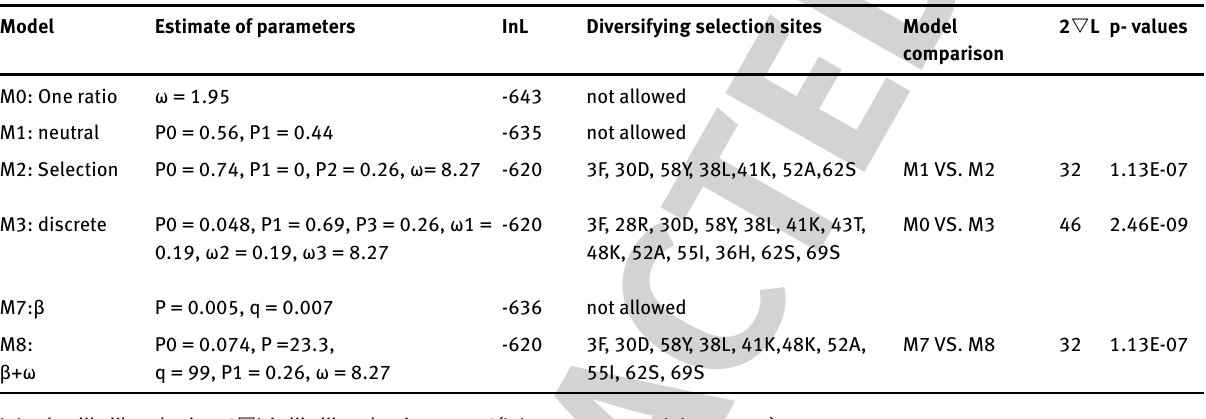
Table 5. Amino acid sites inferred to be under diversified selection